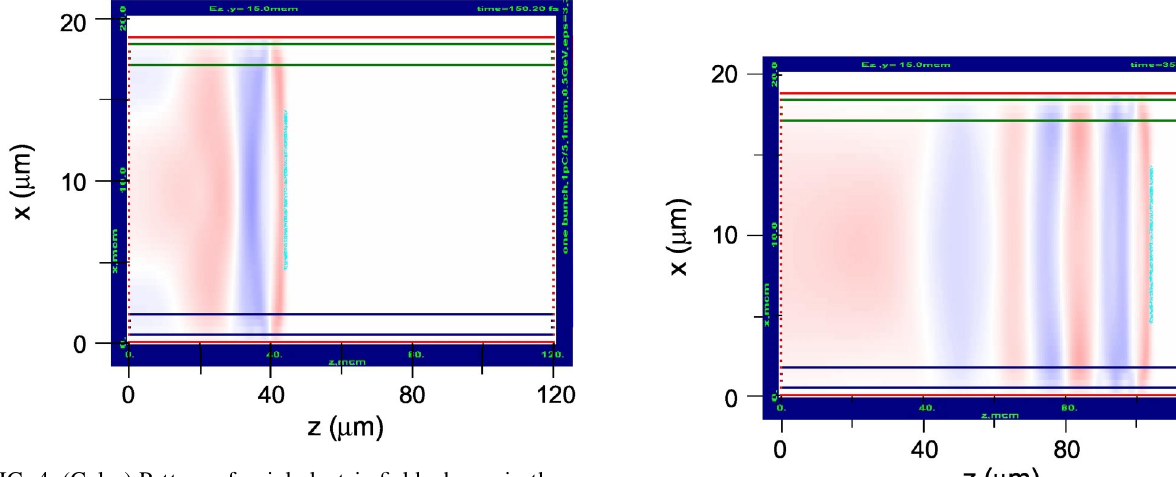
FIG. 4. (Color) Pattern of axial electric field, shown in the z - x plane at midplane y (cid:3) 0 when a bunch has traveled 150 fs from the point of entry on the left. Since the transition radiation is weaker and the Cerenkov radiation has periodicity, the three regions can be approximately distinguished: transition radiation region ( z < 13 (cid:4) m ), interference region ( 13 < z < 26 (cid:4) m ), and Cerenkov radiation region ( 26 < z < 45 (cid:4) m ). In this figure, the total axial length is 120 (cid:4) m .